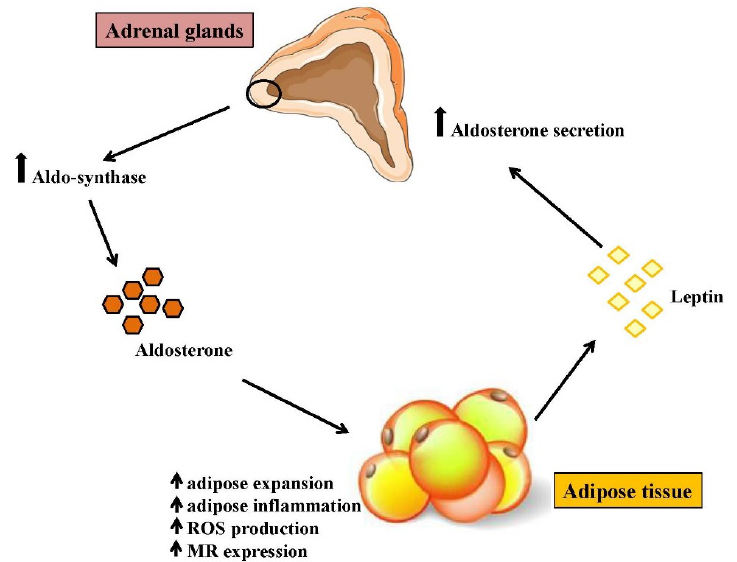
Figure 2. Cross‐talk between adipose tissue and adrenocortical cell. Leptin secreted by adipose